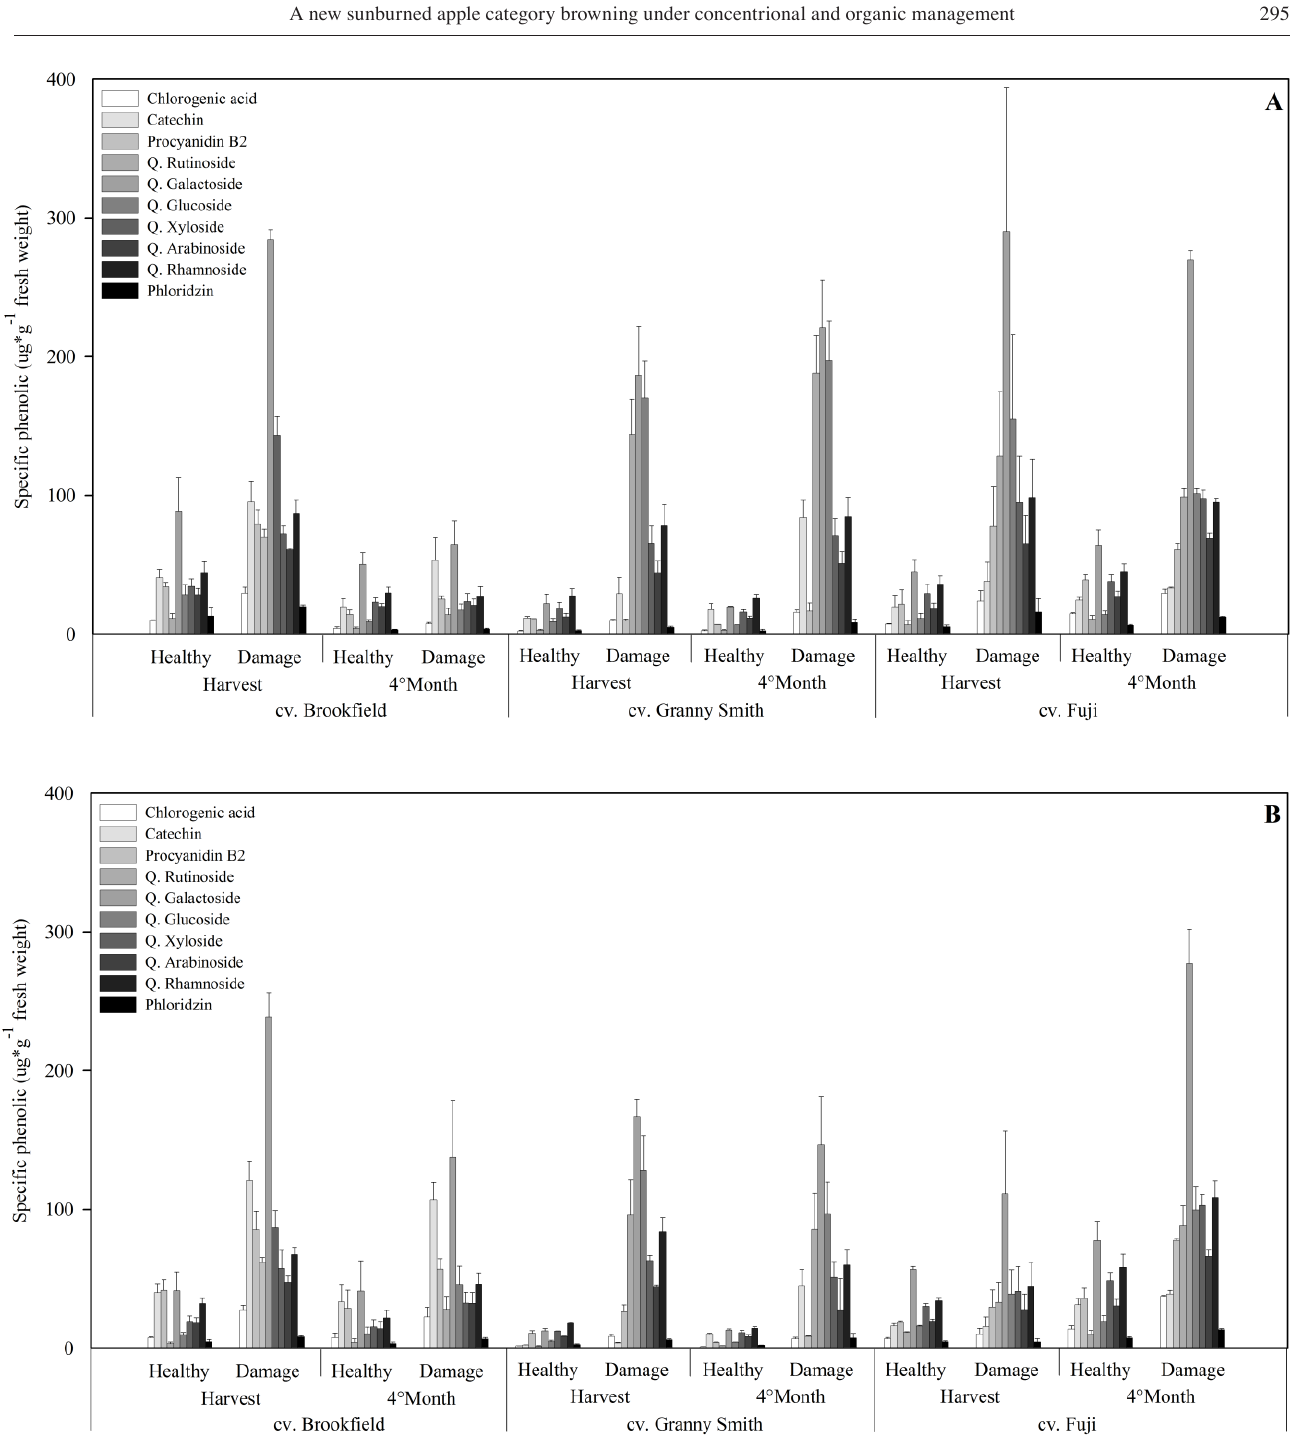
Fig. 8: High-performance liquid chromatography (HPLC). Quantification of specific phenolic compounds in conventional (A) and organic (B)